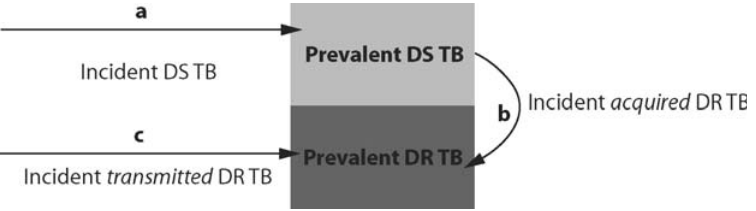
Figure 2. Mechanisms of resistance. Incidence of drug-sensitive TB (DS TB) contributes to the pool of prevalent DS TB (arrow a). Incidence of drug-resistant TB (DR TB) occurs either through acquired drug resistance (arrow b) or through transmitted/primary resistance (arrow